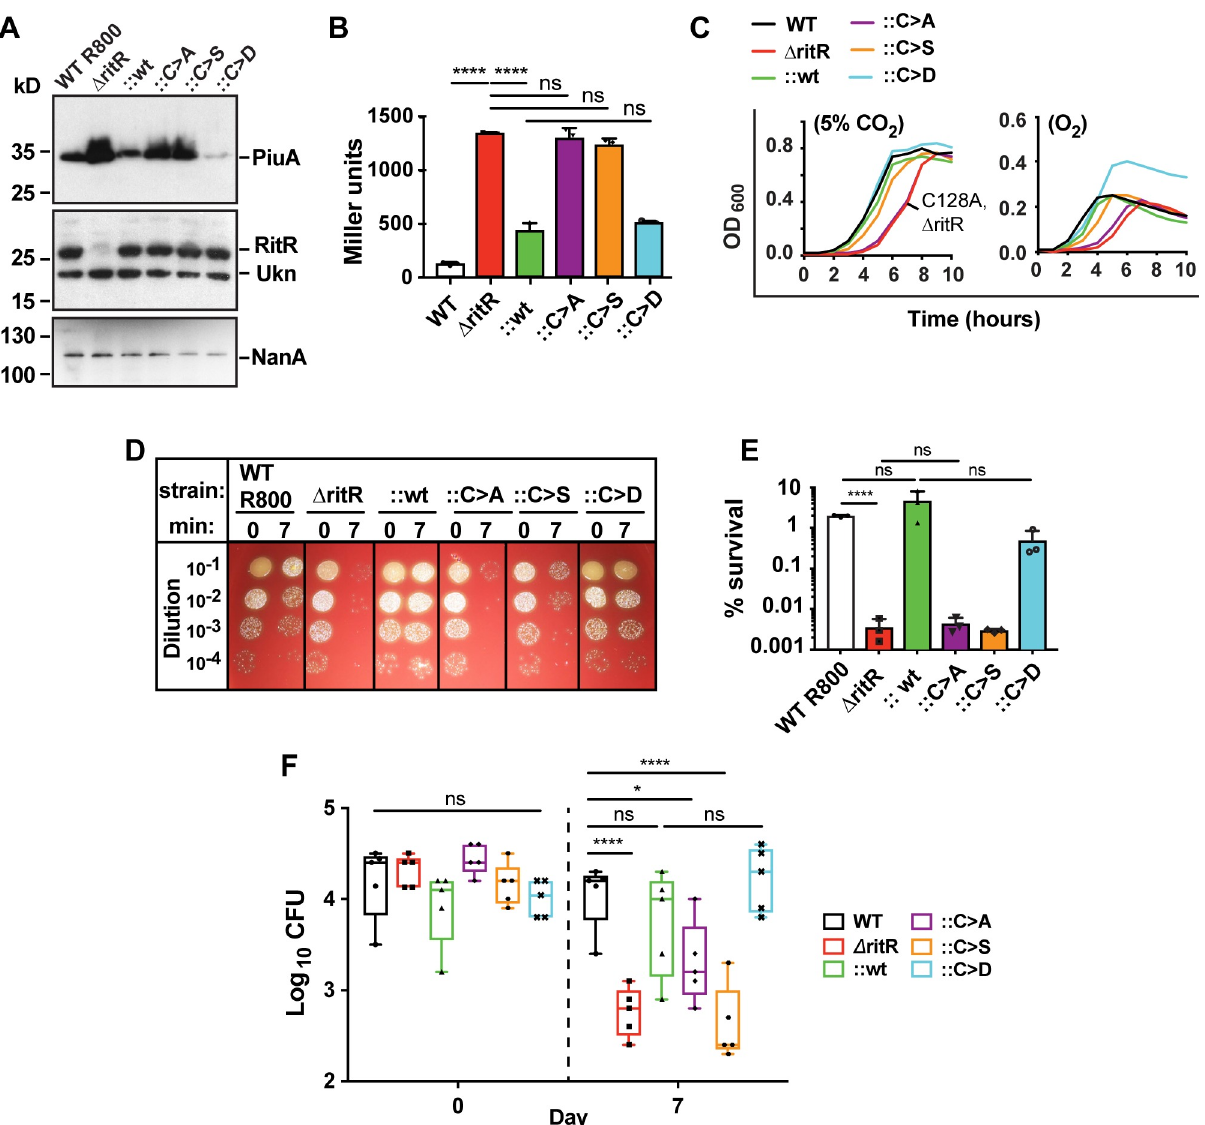
Fig 1. Cys128 is required for growth and regulation of the Piu operon and colonization. ( A ) Western blot analysis representative of three independent experiments of PiuA iron transporter lipoprotein levels in the R800 ritR genetic background variants grown in 5% CO 2 . RitR and NanA are used as controls. Ukn, an unknown cross-reacting protein. ( B ) Piu promoter activity in the genetic background of R800 ritR variants in 5% CO 2 as measured by beta-galactosidase activity and expressed in Miller units. ( C ) Growth comparison of wild-type D39 cells plus ritR variants under static 5% CO 2 and aeration (O 2 ) conditions. ( D ) Streptonigrin killing assay representative of three biological repeats. ( E ) Bar graph of three independent experiments as shown in D . ( F ) Ability of D39 variants to colonize the murine nasopharynx. Mice were inoculated and the colonization let run for 7 days before cells were collected and plated to determine CFUs. Statistics . Colonization data were analyzed by analysis of variance followed by Tukey’s multiple comparisons test. Statistical significance was considered to be a p-value of < 0.05. Each point indicates the CFUs retained in a single animal. Graphs in B and E represent the mean of three independent experiments. Error bars represent +/- standard deviation. One asterisk indicates a p-value of (cid:20) 0.05, two of (cid:20) 0.01, three of (cid:20) 0.001, and four of (cid:20) 0.0001 as determined by one-way ANOVA followed by Tukey’s multiple comparison test in B , and a two-tailed students t-test in E . ns, not